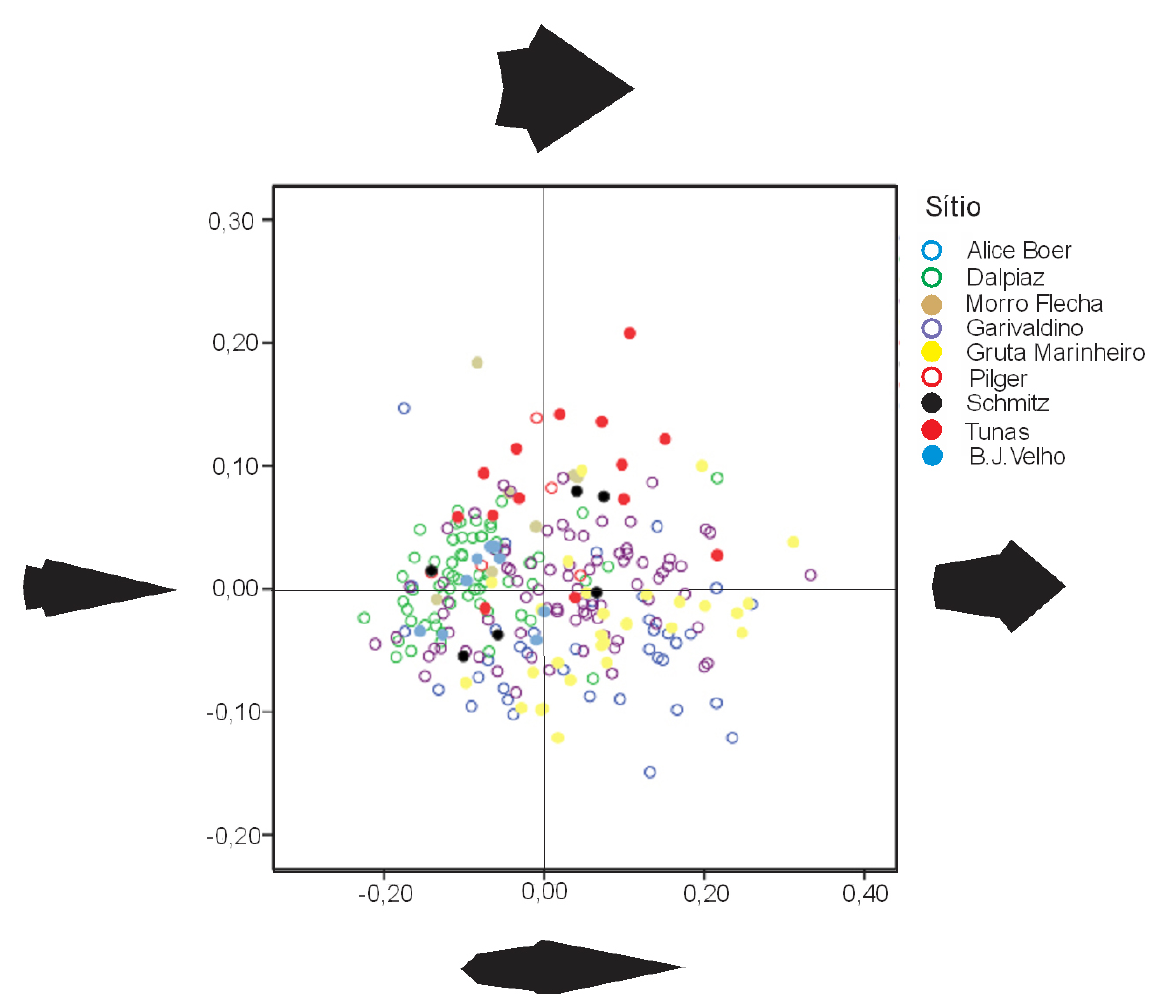
Figura 4. Gráfico de Análise de Componentes Principais das coordenadas da forma. As formas extremas de cada eixo são apresentadas. Figure 4. Principal Components Analysis graph of the shape coordinates. The extreme shapes of each axis are